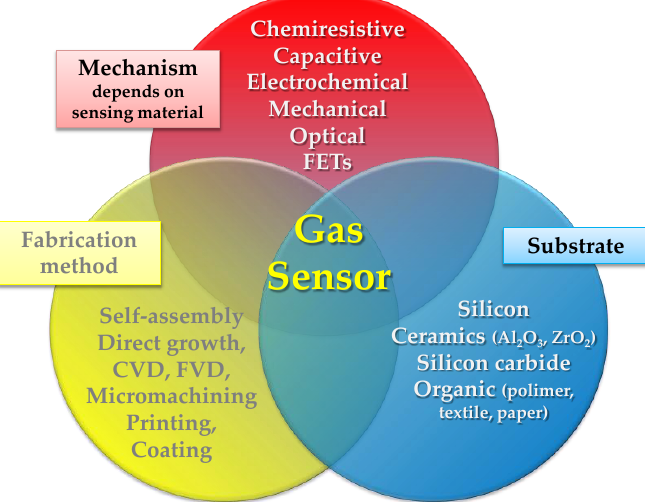
Figure 3. Scheme of the most used sensing mechanisms, substrates and fabrication methods to develop a gas sensor.